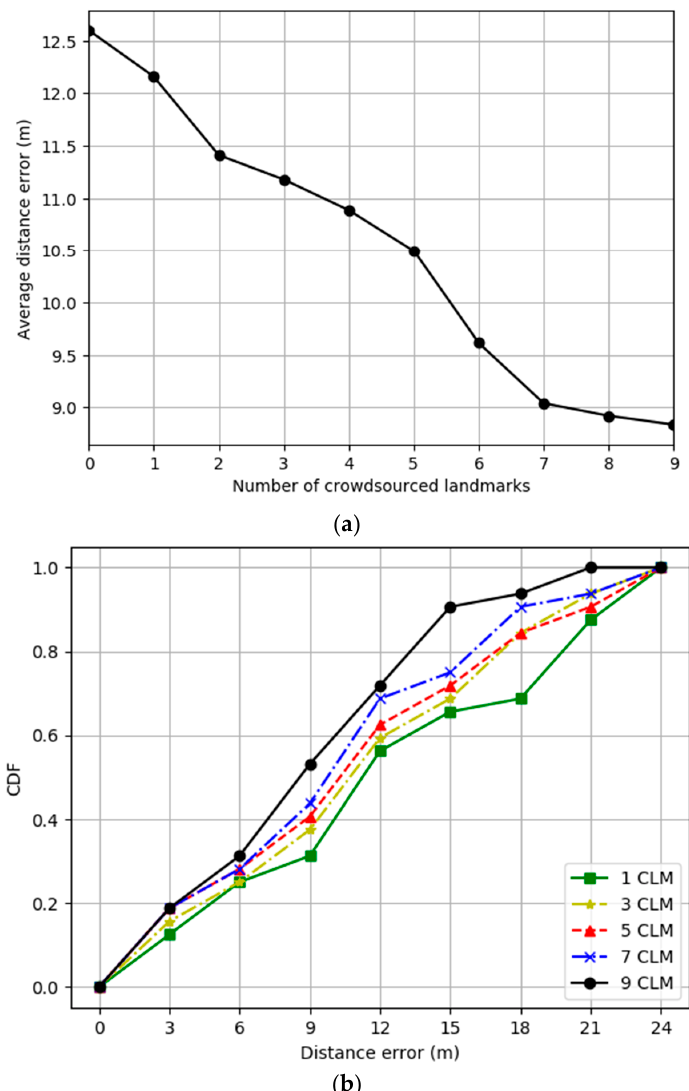
Figure 8. ( a ) Average distance error as a function of the number of crowdsourced landmarks; ( b) cumulated distance error for the ground-truth reference path for varying number of crowdsourced landmarks